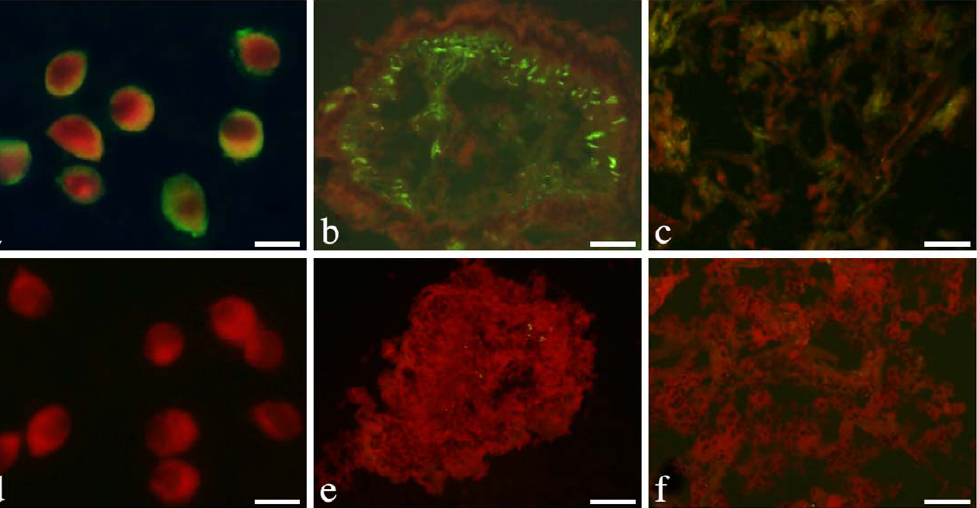
Figure 4. Localization of endogenous CfLec-1 in different tissues. Hemocytes or 7 m m thick frozen sections of gill, adductor muscle, gonad, hepatopancreas, mantle and kidney were fixed with acetone and then incubated with rat polyclonal antiserum to CfLec-1. Binding of antibody to CfLec-1 was visualized by FITC-labeled secondary antibody (green), and the whole tissues were stained with EBD (red). a and d: hemocytes, bar=10 m m; b and e: mantle, bar=50 m m; c and f: gill, bar=50 m m.